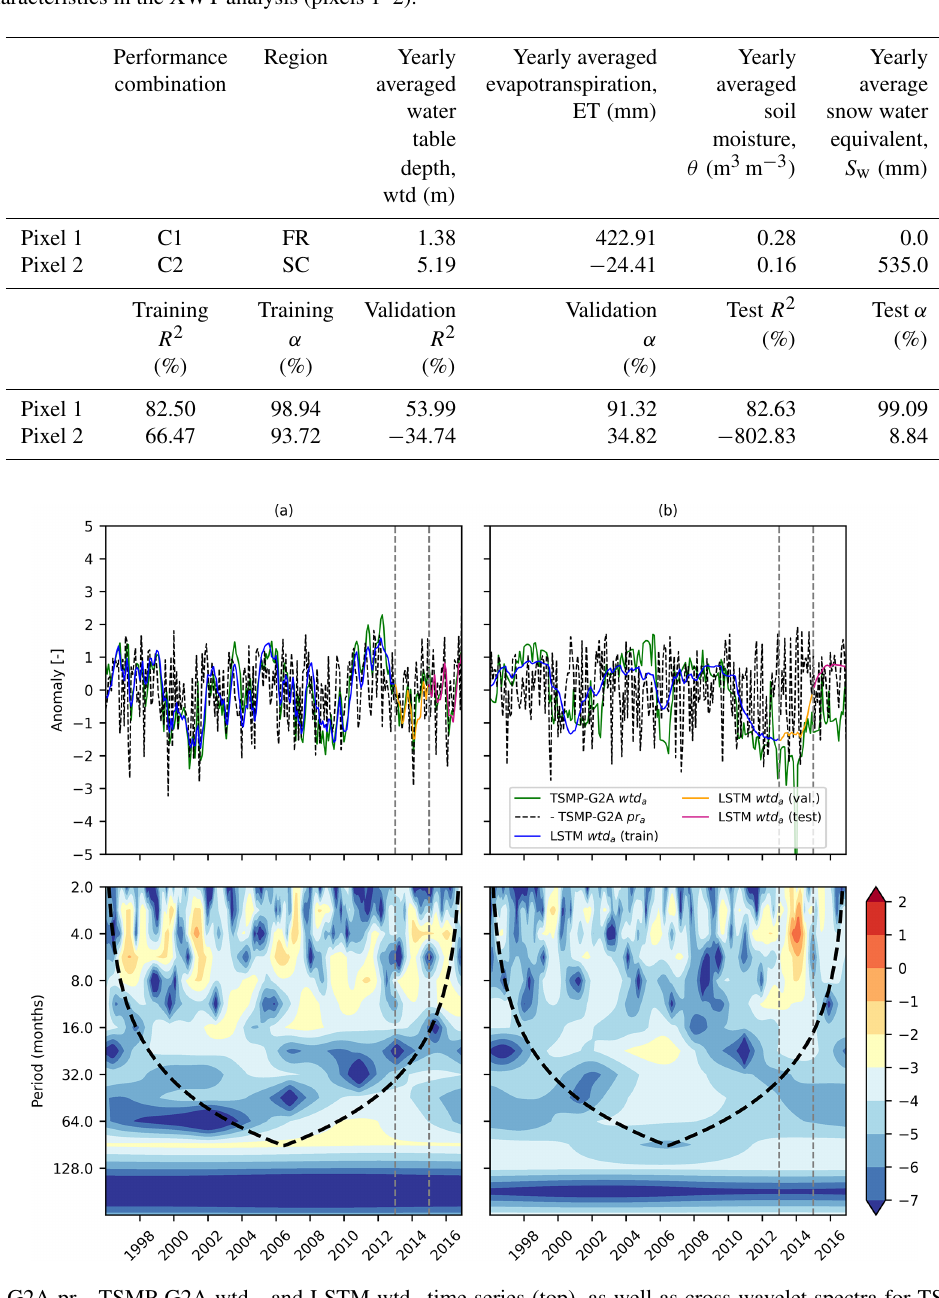
Figure 9. TSMP-G2A pr a , TSMP-G2A wtd a , and LSTM wtd a time series (top), as well as cross-wavelet spectra for TSMP-G2A pr a and wtd a series (bottom), at a representative pixel of the performance combination (a) C1 and (b) C2. In the cross-wavelet spectra, the black dashed line marks the boundary of the cone of influence. The color bar presents log 2 (power/scale). In all plots, the two gray dashed lines separate the study period into the training, validation, and testing